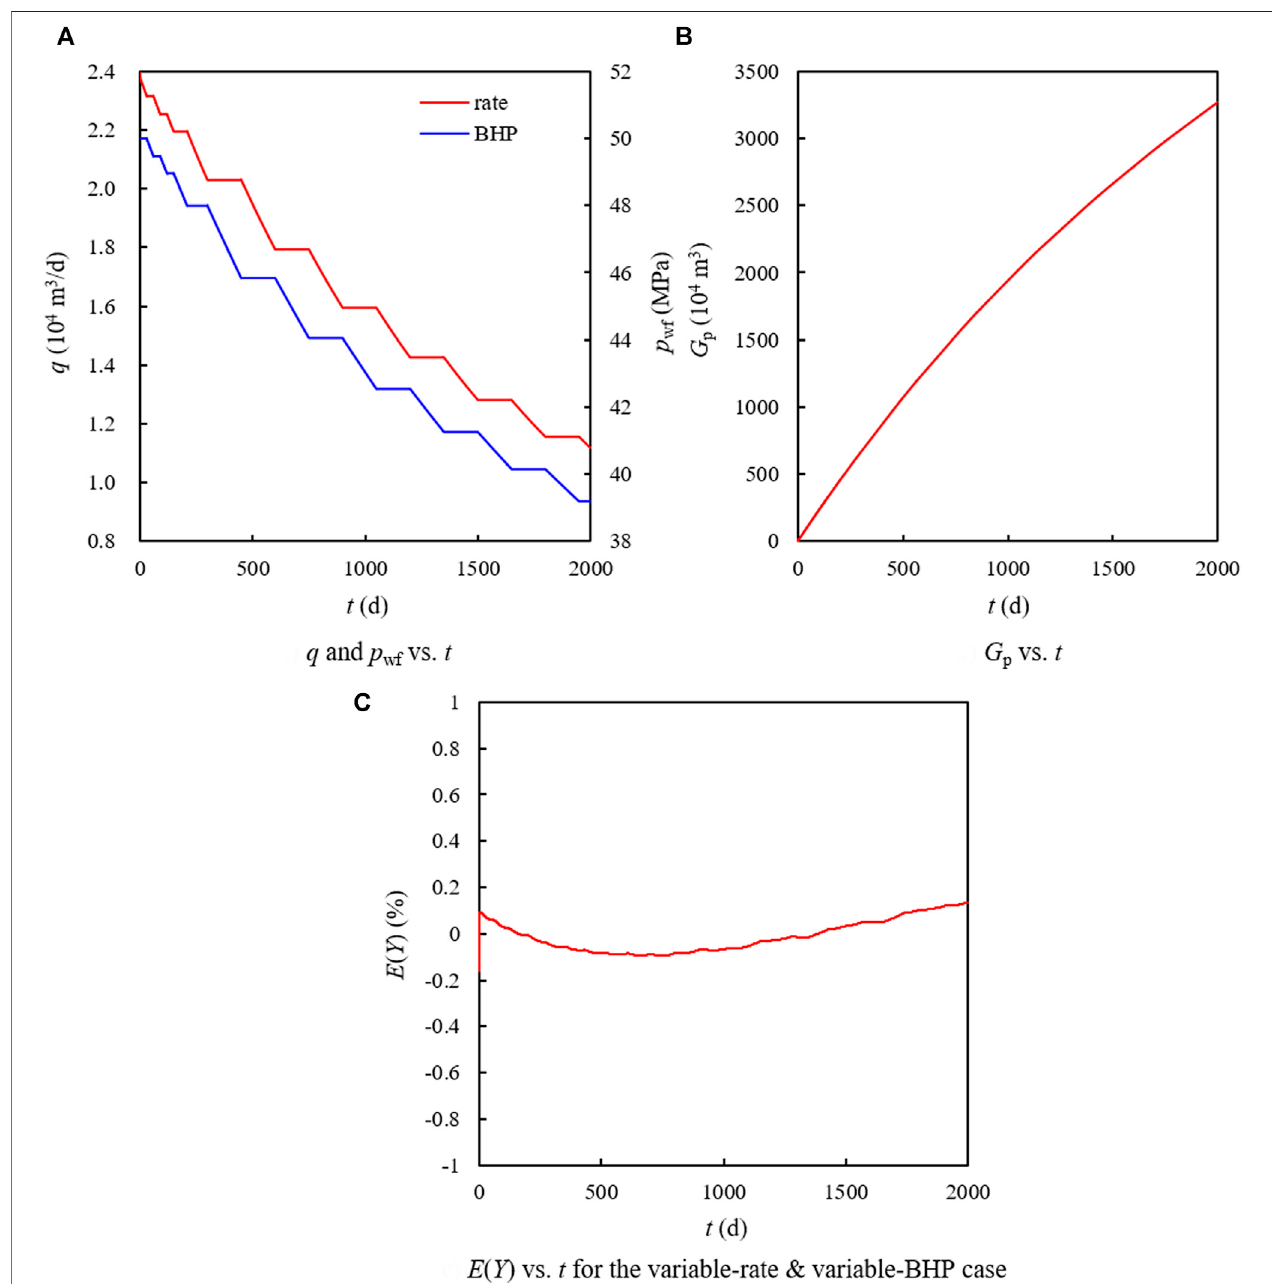
FIGURE 8 | The pro fi les of production rate, BHP, G p and E ( Y ) for the variable-rate and variable-BHP case.